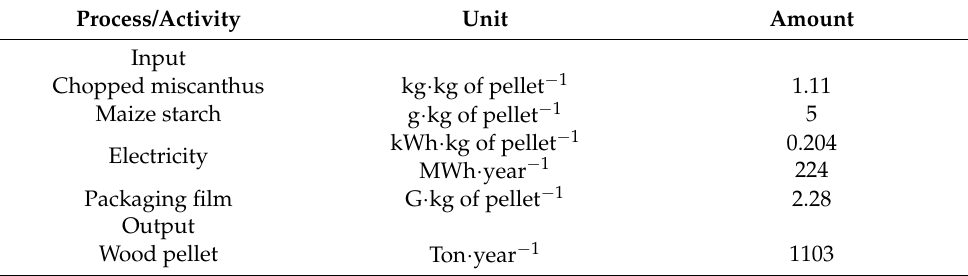
Table 2. Life cycle inventory data for miscanthus pellet